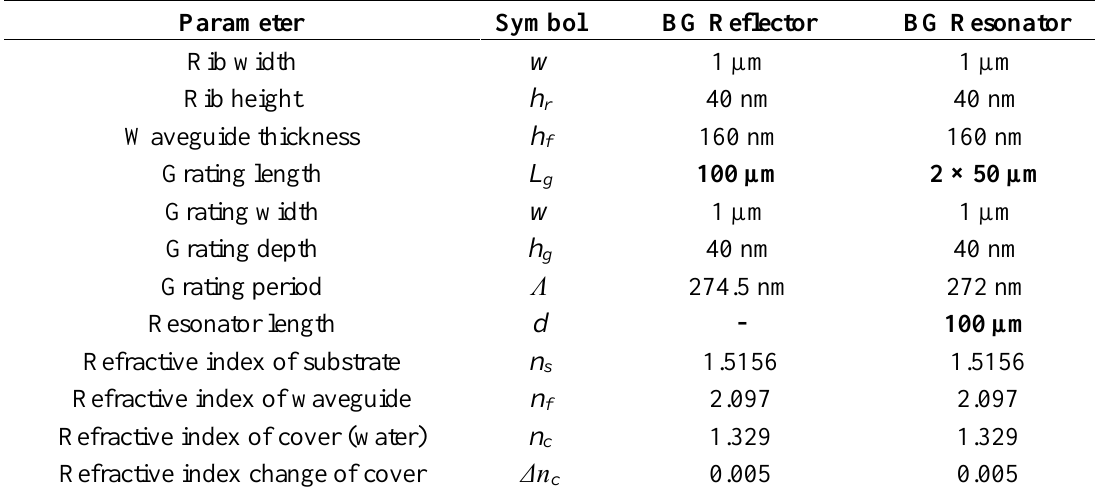
Table 1. Input Parameters for Simulation of the BG Reflector and